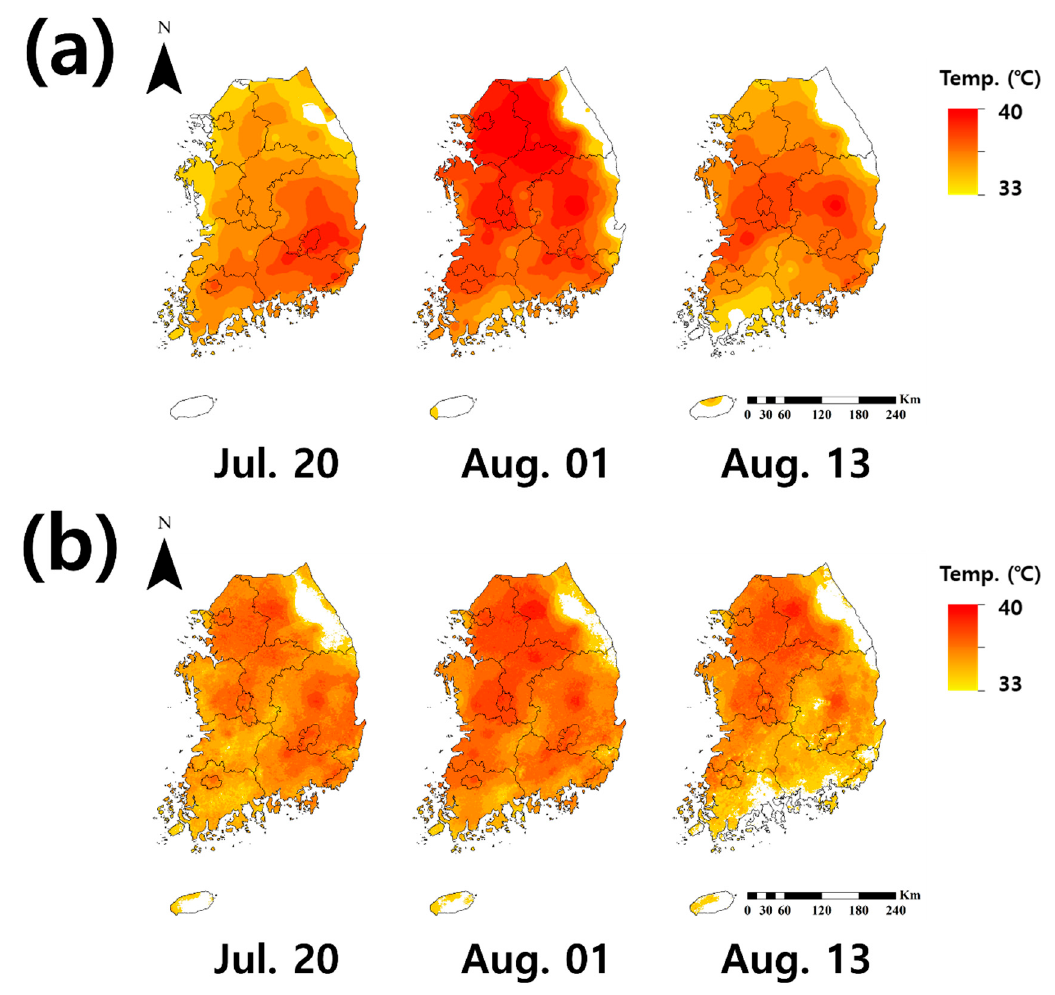
Figure 9. Spatial T MX distribution of ( a ) observed T MX and ( b ) predicted T MX on July 20, August 1, and August 13, 2018, during the heat wave period. The temperature range was set from 33 to 40 °C to express the distribution of heat wave occurrence.